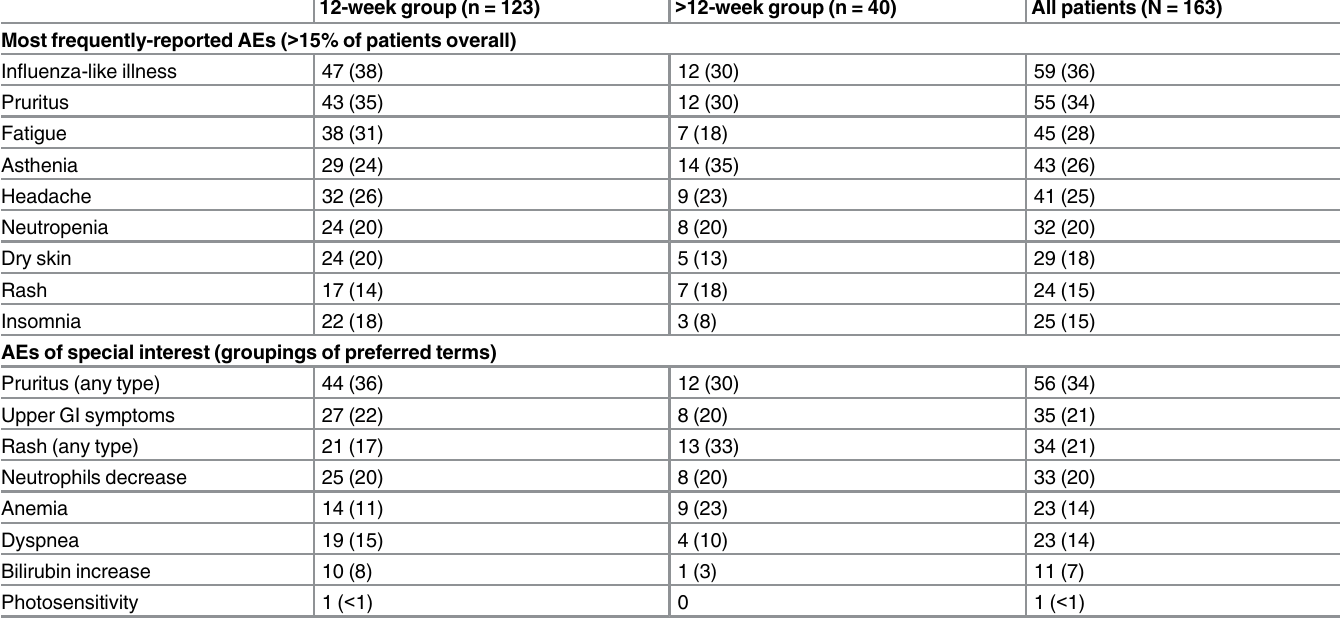
Table 3. Listing of most frequently-reported AEs ( > 15% overall) and all AEs of special interest. AE, adverse event; GI,